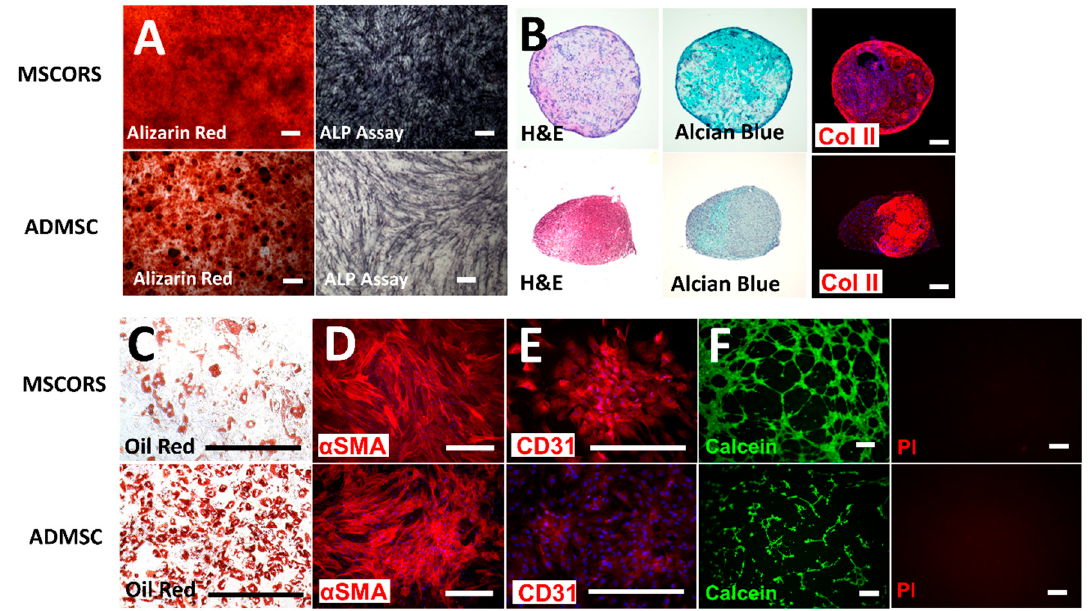
Figure 3. Differentiation competences of MSCORS and ADMSC. ( A ): Osteogenic differentiation for 28 days. The extracellular CaP deposition in MSCORS and ADMSC ( n = 5) was displayed by Alizarin Red staining, and intracellular ALP activity was visualized by BCIP/NBT. ( B ): Chondrogenic differentiations of MSCORS and ADMSC for 28 days by pellet culture ( n = 5). Chondrogenesis was assessed via H&E and Alcian Blue for proteoglycan content. Type II collagen was identified via immunostaining. ( C ): Adipogenic differentiation of MSCORS and ADMSC for 21 days ( n = 5). The intracellular lipid vesicles were detected by Oil Red O staining. ( D ): Smooth muscle differentiation for 21 days was evaluated via α SMA immunostaining ( n = 5). ( E ): Endothelial differentiation of MSCORS and ADMSC for 21 days detected via immunostaining for CD31 ( n = 5). ( F ): The potential for vascular anastomosis was investigated using a tube forming assay and highlighted by Live/Dead staining of Calcein AM and PI, respectively, displayed in separate channels ( n = 5). Immunostaining was counterstained with DAPI. Scale bar corresponds to 200 μ m; magnification ( A ) 4×, ( B ) 4×, ( C ) 20×, and ( D ) 10×, 20×, and 4×.